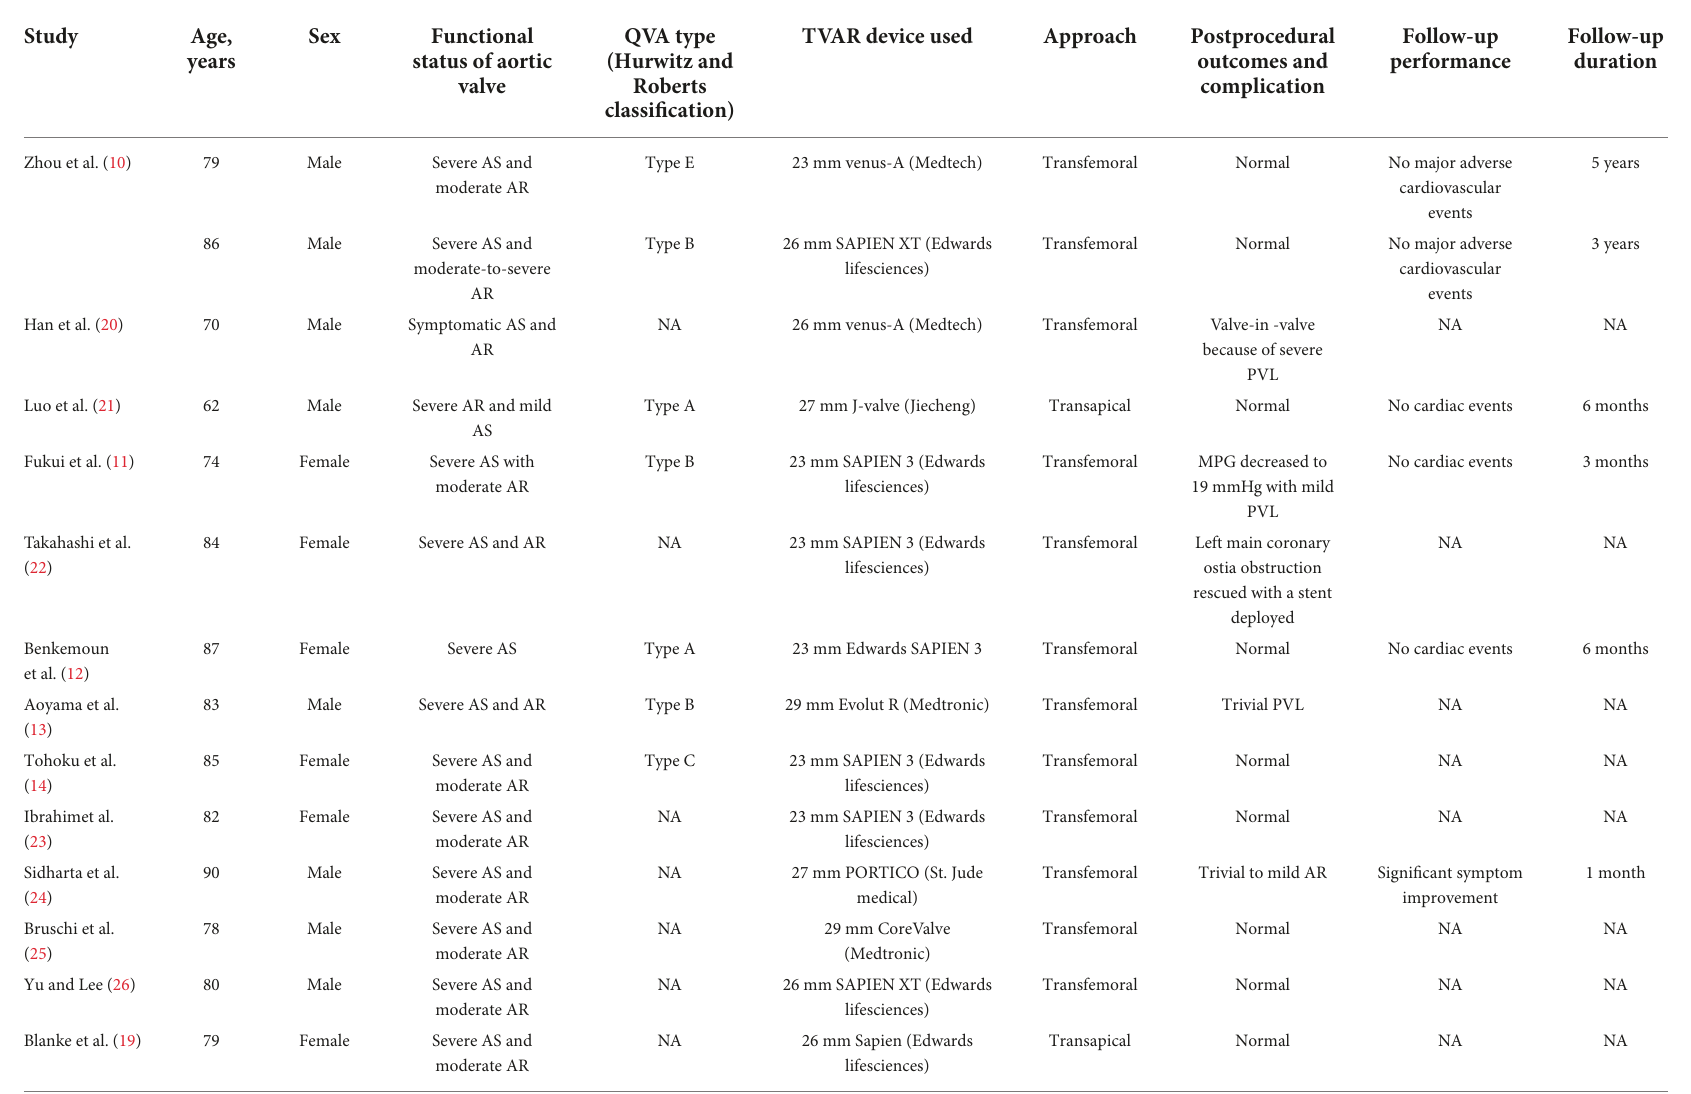
TABLE 4 Summary of the literature on quadricuspid aortic